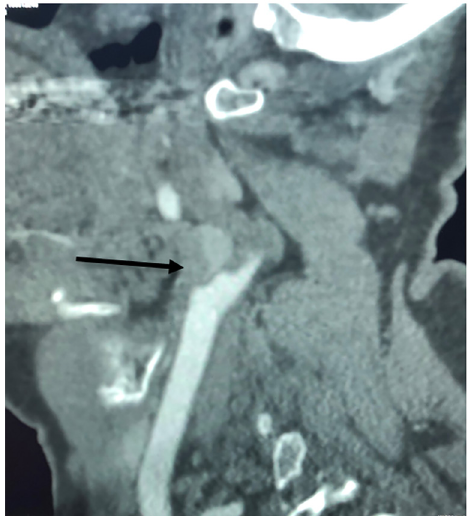
Image 3. Computed tomography demonstrating complete occlusion of the left internal carotid artery depicting “flame occlusion”